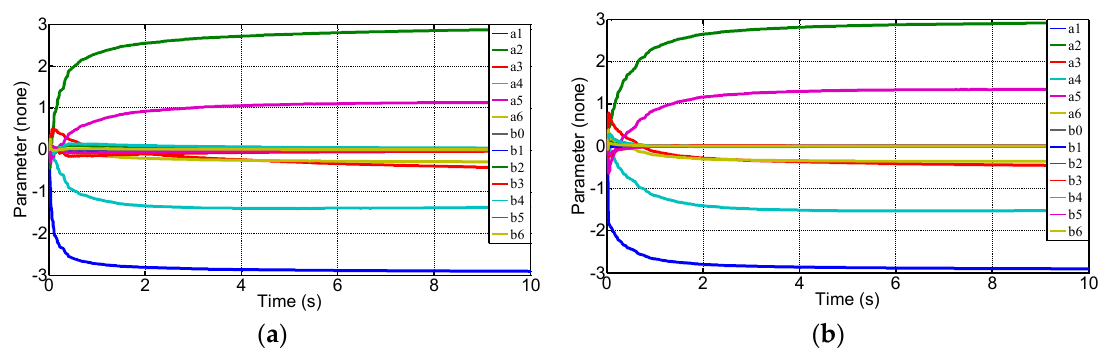
Figure 22. The system model parameters using recursive least squares (RLS) algorithm. ( a ) 1#_shaking